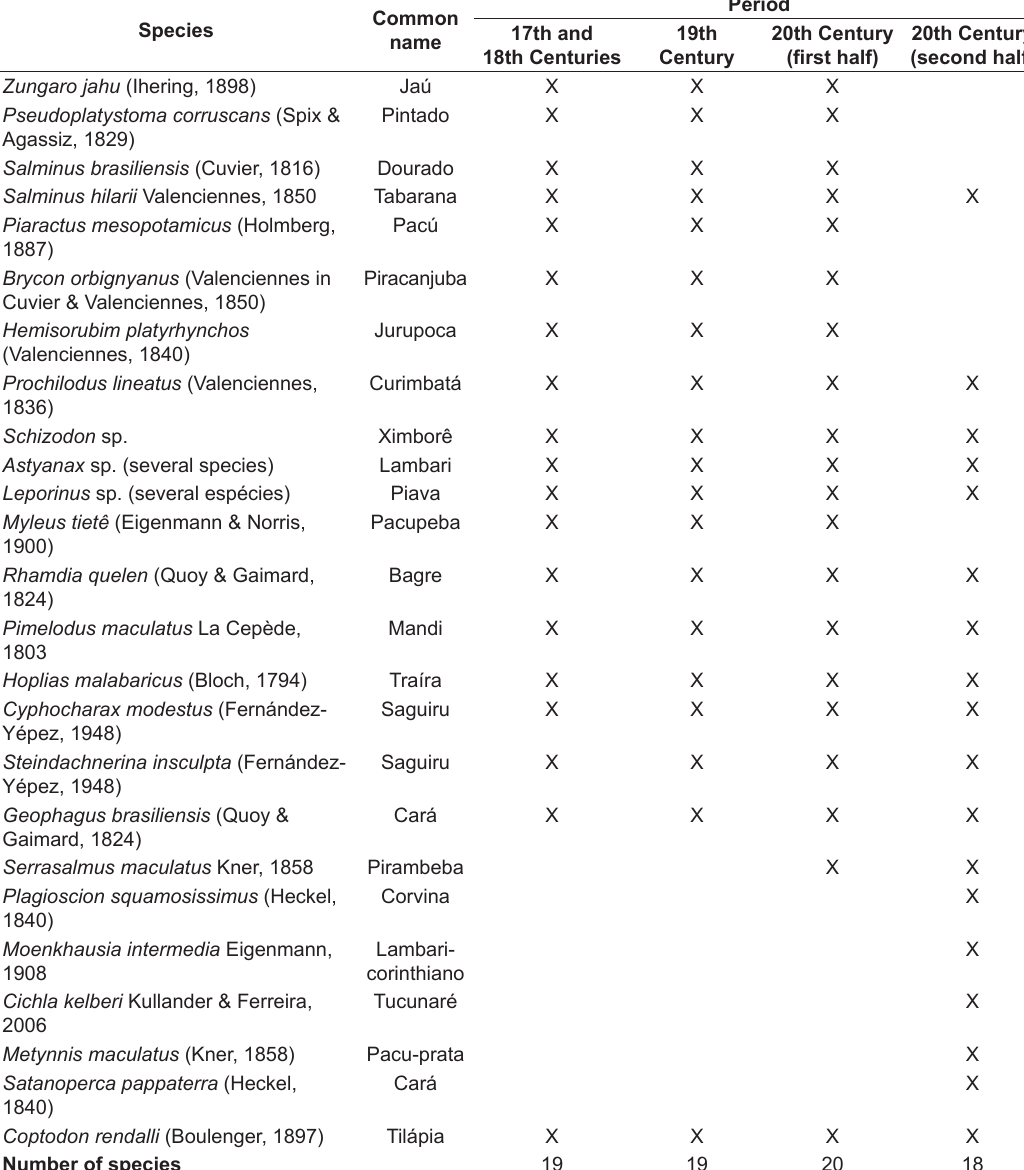
Table 3. Main fish species captured by fishing (amateur, sports and experimental) in the Tietê River, SP, Brazil, from the 17th Century to the current